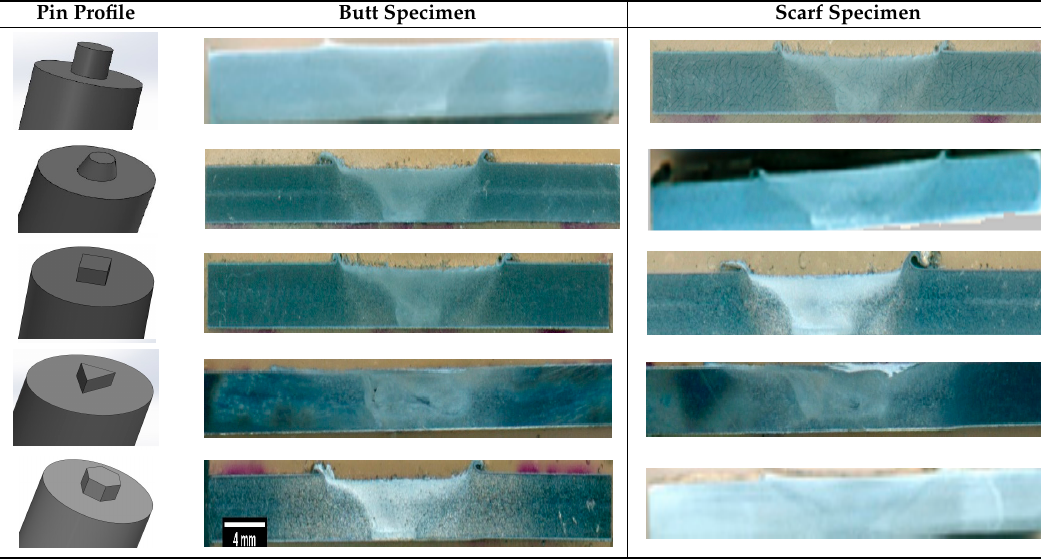
Table 4. Welding parameters that are constant during welding.